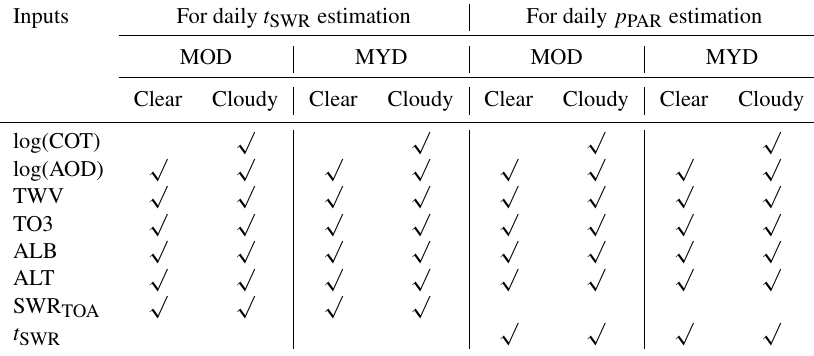
Table 1. Summary of machine learning model inputs for the estimation of t SWR and p PAR . Daily estimations from MOD and MYD atmo- sphere data are averaged. Inputs For daily t SWR estimation For daily p PAR estimation MOD MYD MOD MYD Clear Cloudy Clear Cloudy Clear Cloudy